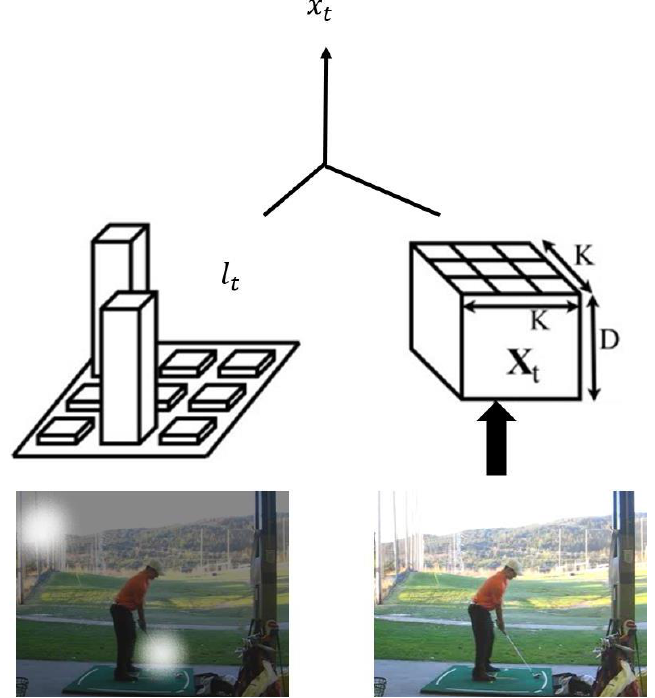
Figure 4. Soft attention mechanism. The CNN takes video frame as its input and produces a feature cube. The model computes the current input x t as an average of the feature slices weighted according to the location softmax I t